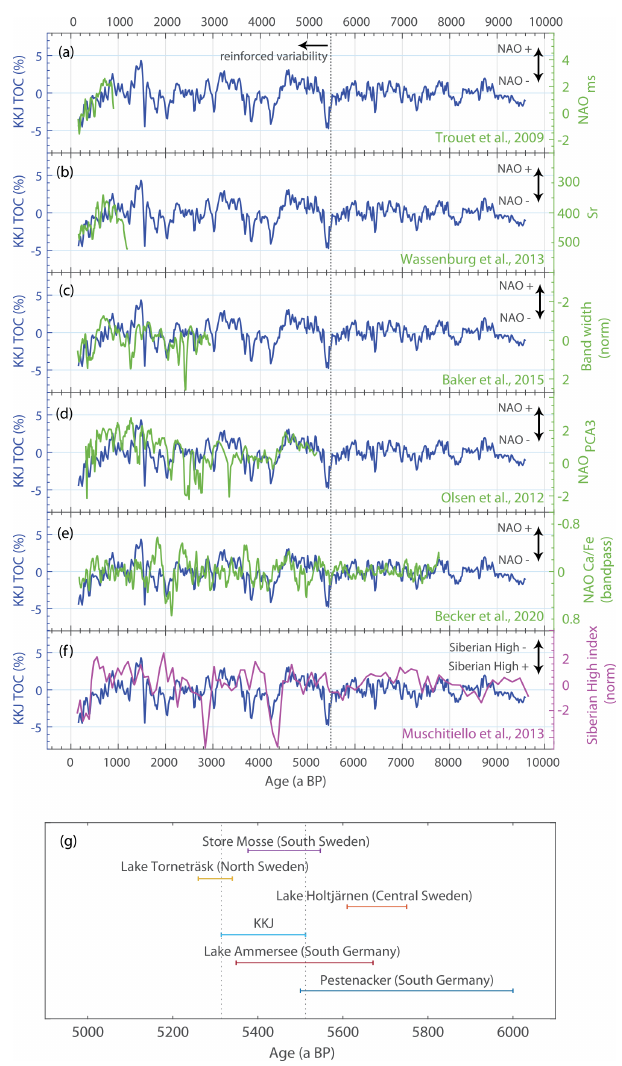
Figure 12. Decadal to centennial paleoclimate records covering the last ∼ 9600 years. (a–e) Total organic carbon (TOC) record from Lake Kälksjön (KKJ) sediments with reconstructions of the North Atlantic Oscillation (NAO). (f) TOC record from KKJ with a proxy for Siberian High strength. Multi-millennial variability was removed from the KKJ TOC record by subtracting a 2500-year low-pass-filtered version from the original time series. (g) Timing of regime shifts in atmospheric circulation from north–central Eu- ropean paleoclimate records during the proposed reinforcement of NAO variability imprinted in KKJ sediments (Czymzik et al., 2013; Giesecke, 2005; Köhler et al., 2022; Kylander et al., 2013; Thiene- mann et al.,